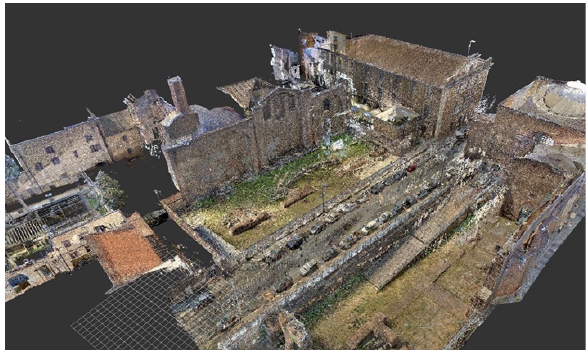
Figure 08 . Image of the point cloud cleaned up, after eliminating all the context not relevant to the survey project and the elements that obstructed the process of knowing the artifact. The point size in the image is 1. This way the visualization of the model is clearer. Figure 09 . Plan of level 00 of the Sala Ottagona. Since the floor is horizontal, it was chosen as the relative height 0. All the dimensions within the survey therefore refer to the internal floor of the room. The slope inside the Sala is less than 1% starting from the